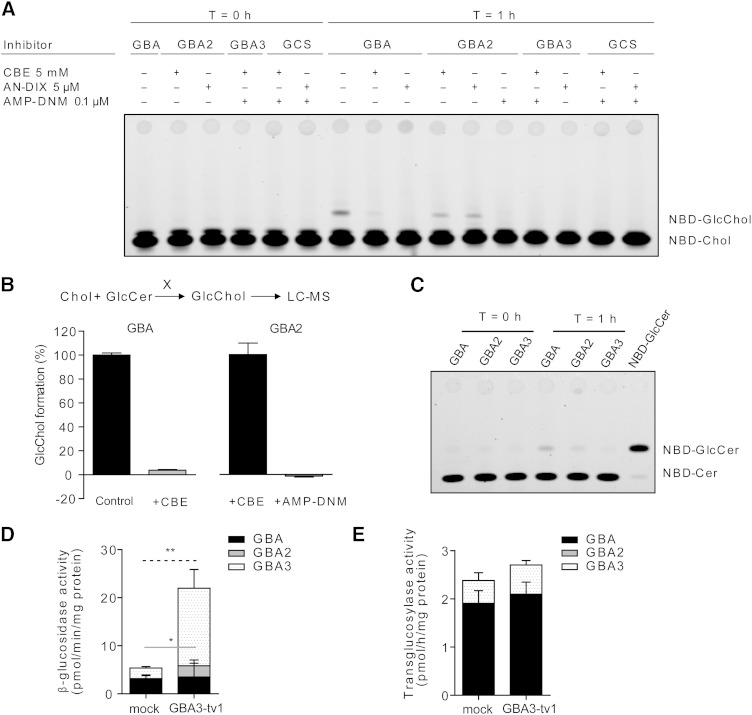
In vitro transglucosylation of 25-NBD-GlcChol by GBA and GBA2. A: rGBA and lysates of cells with overexpression of GBA2, GBA3, and GCS were incubated for 0 and 1 h with 25-NBD-cholesterol in the presence of C18:1-GlcCer as donor, and in the absence or presence of the respective specific β-glucosidase inhibitors: CBE (GBA), AMP-DNM (GBA2), and anDIX (GBA3) (26). Formation of 25-NBD-GlcChol was detected by HPTLC and fluorescence scanning. B: rGBA (in absence or presence of CBE) and lysates of cells with overexpression of GBA2 (in presence of CBE and in absence or presence of AMP-DNM) were incubated for 0 and 1 h with cholesterol in the presence of C18:1-GlcCer as donor. Formation of GlcChol was detected by LC-MS. The percentage of inhibition of GlcChol formation by the respective inhibitors is shown. Data presented as mean ± SD. C: rGBA and lysates of cells with overexpression of GBA2 and GBA3 were incubated for 0 and 1 h with GlcChol in the presence of NBD-Cer. Formation of NBD-GlcCer was detected by HPTLC and fluorescence scanning. D: β-Glucosidase activity in lysates of CHO-K1 cells overexpressing GBA3. The activity was measured in the absence or presence of the specific β-glucosidase inhibitors: 0.5 mM CBE and/or 0.3 mM NB-DGJ. CBE- and NB-DGJ-sensitive activities were defined as activities derived from GBA (black box) and GBA2 (gray box), respectively. CBE- and NB-DGJ-insensitive activity was defined as activity derived from GBA3 (dotted box). Mock represents the cells transfected with empty vector. E: Transglucosylase activity in lysates of cells with overexpression of GBA3. Data (n = 3, mean ± SD) were analyzed using an unpaired t-test. *P < 0.05 and **P < 0.01. Black, gray, and dotted lines show the significant difference of the activity derived from GBA, GBA2, and GBA3, respectively.